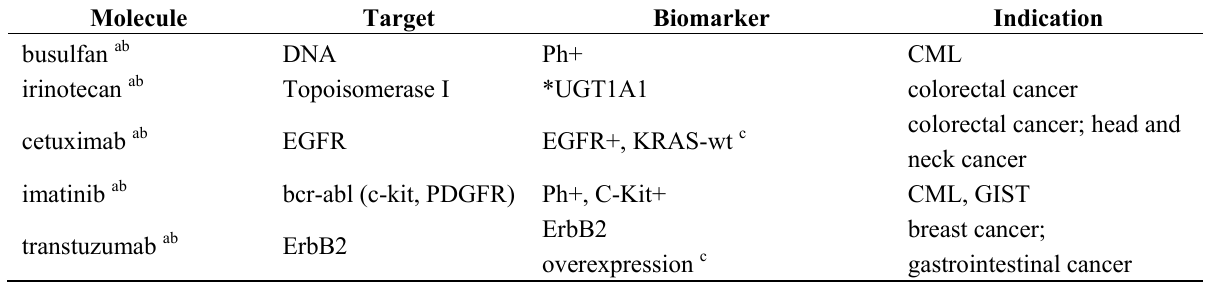
Table 2. Approved cancer drugs that can be used with biomarker